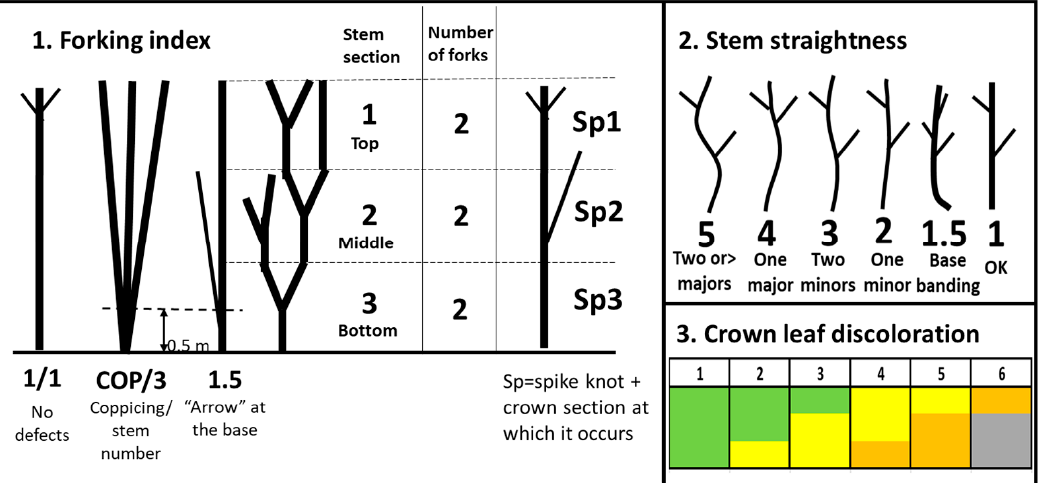
Figure 1. Methods for scoring the stem morphotype. (1) forking index was scored by estimating at which part of the stem forking defect is located and the number of forks (e.g., the tree with most forks in figure above 3 × 2 + 2 × 2 + 2 × 2 + 1 × 2 = 16). The number of forks given in the figure is an example referring the left most forked tree at the left box of the figure. The score 1.5 notes the straight trees containing being at the very base. COP3 notes the tree from originated coppicing (not applica- ble for beech). 1/1 is tree with no defects (1 stem and 1 fork). Autumn leaf senesce shows dominant leaf color of the crown, where grey color in stage 6 indicates leaf-free sections, whereas color green in stage 1 indicates green leaves.